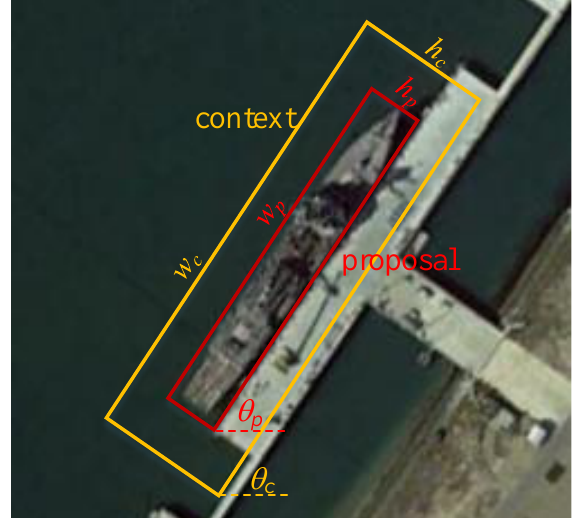
Figure 8. Contextual information of a region